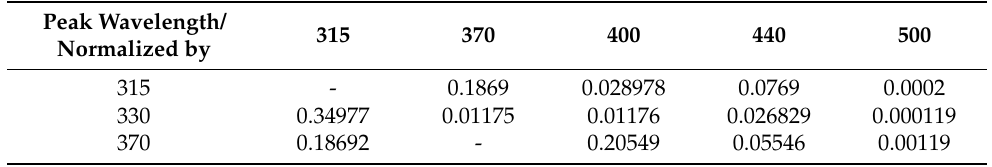
Table 2. The magnitude of the error of the second kind ( p -value) for the Mann–Whitney U test for